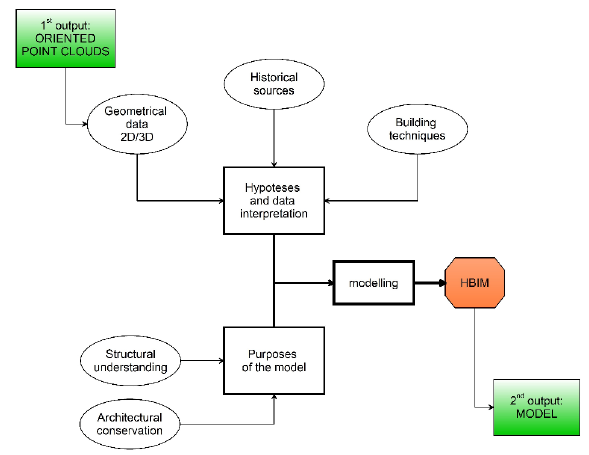
Figure 3. Flowchart explaining the proposed methodology: starting from the pointclouds and basing on hypoteses and data interpretation and considering the possible purposes of the model